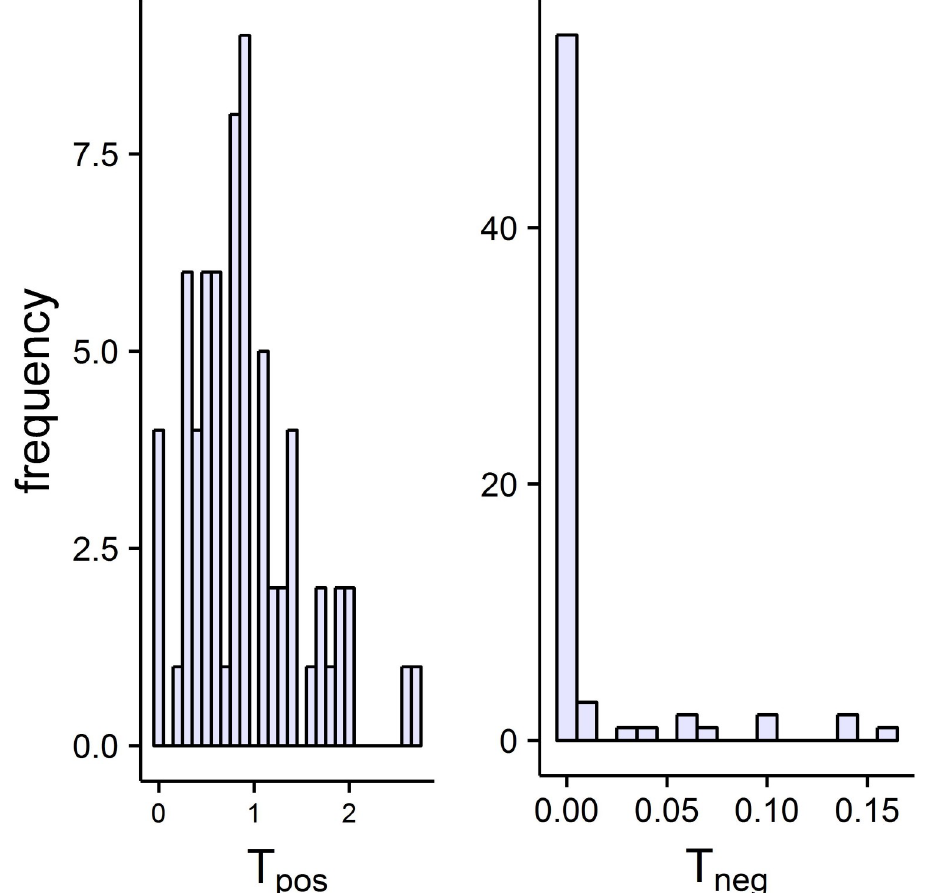
Fig 7. Histograms of T pos and T neg for all 68